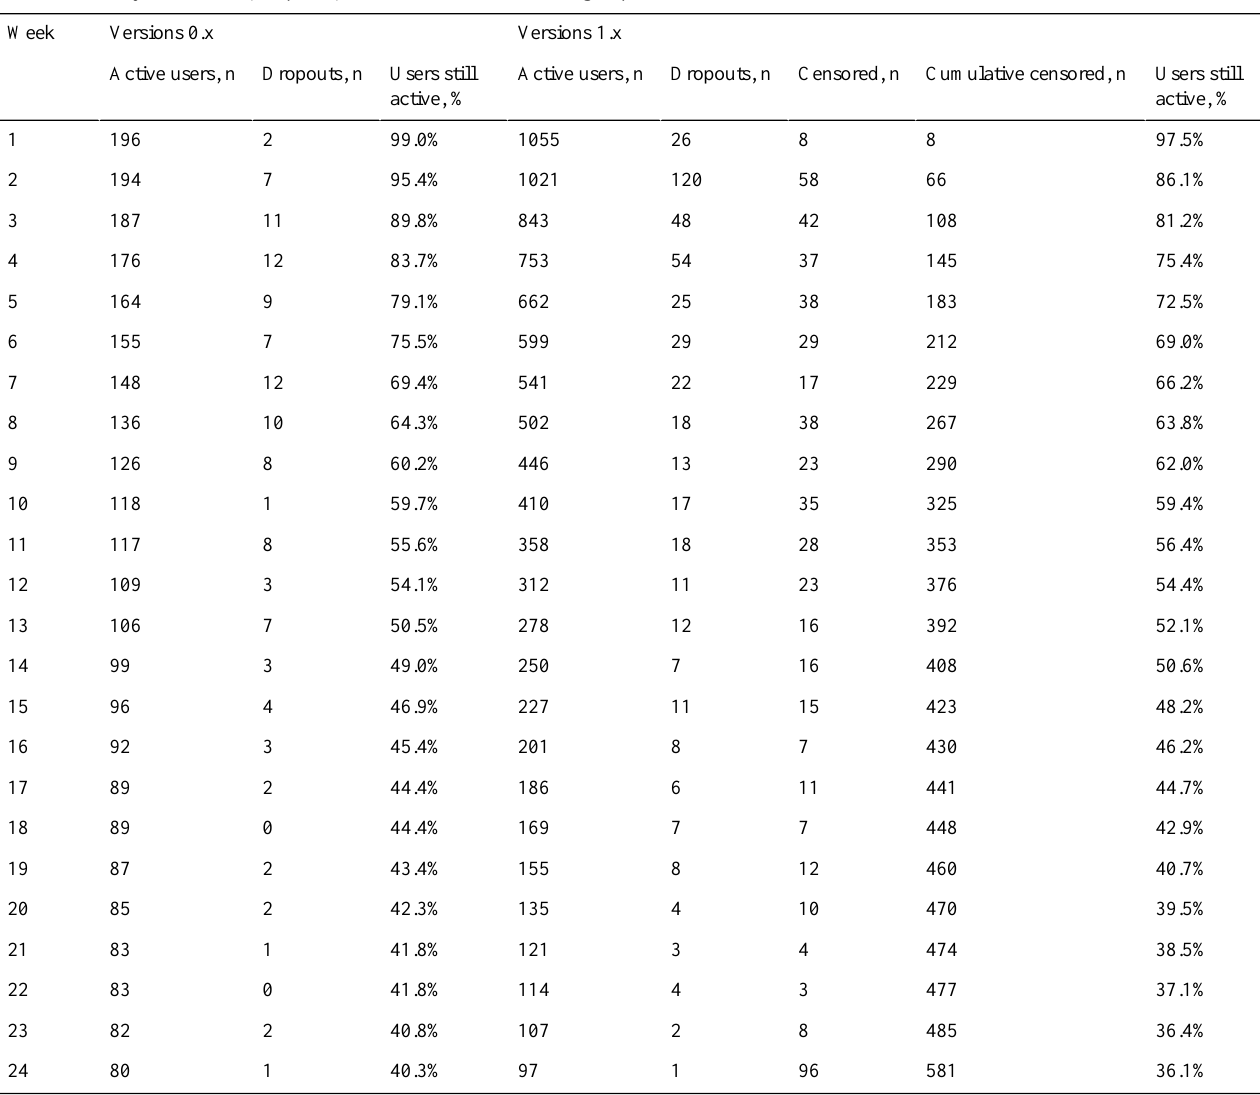
Table 3. Weekly active users, dropouts, and censored users for both